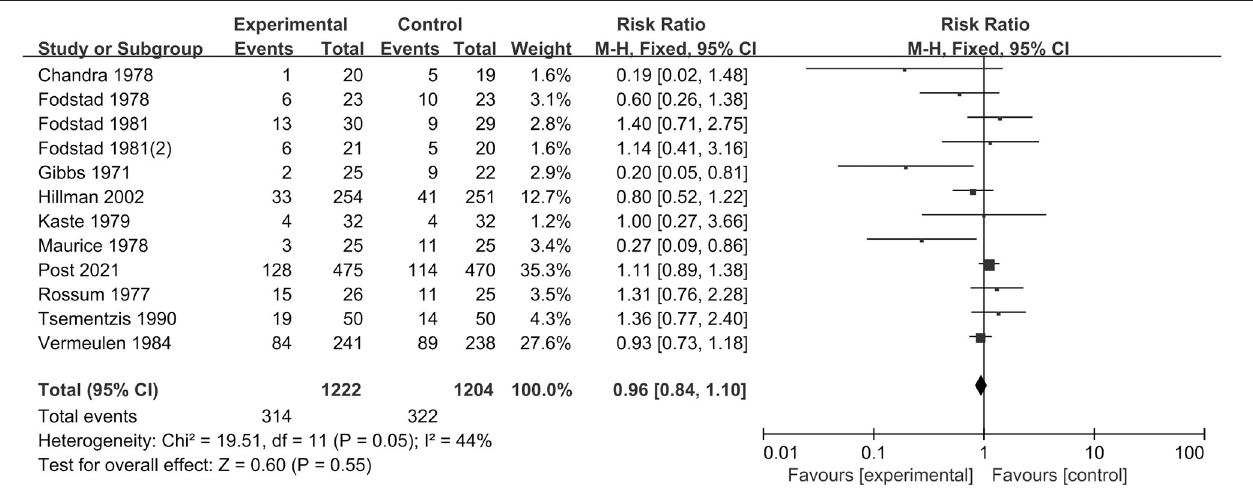
FIGURE 2 | Forest plot comparing tranexamic acid and control treatment for the outcome of all-cause mortality.